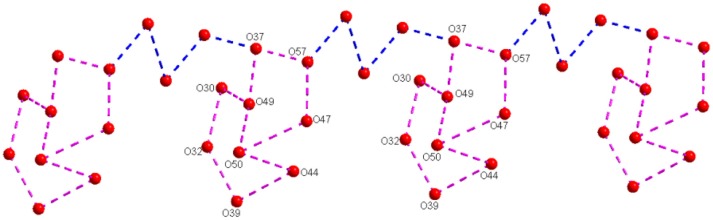
A chainlike water structure, built from water cluster due to O–H···O interactions among the lattice water and zinc and sodium coordinated water molecules in the crystal structure of compound [Zn(H2O)6][Na3(H2O)14][HV10O28]·4H2O (2).